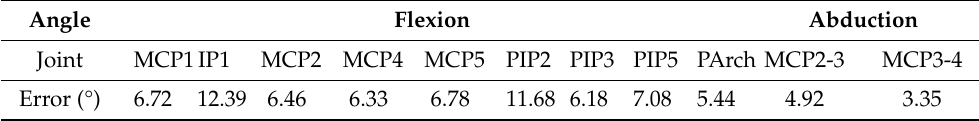
Table 5. Errors ( ◦ ) when estimating entire hand kinematics from the recording of joint angle flexions of the metacarpophalangeal joint of the middle finger and the proximal interphalangeal joint of the ring finger, abduction between ring and little fingers, and abduction and flexion of the thumb carpometacarpal